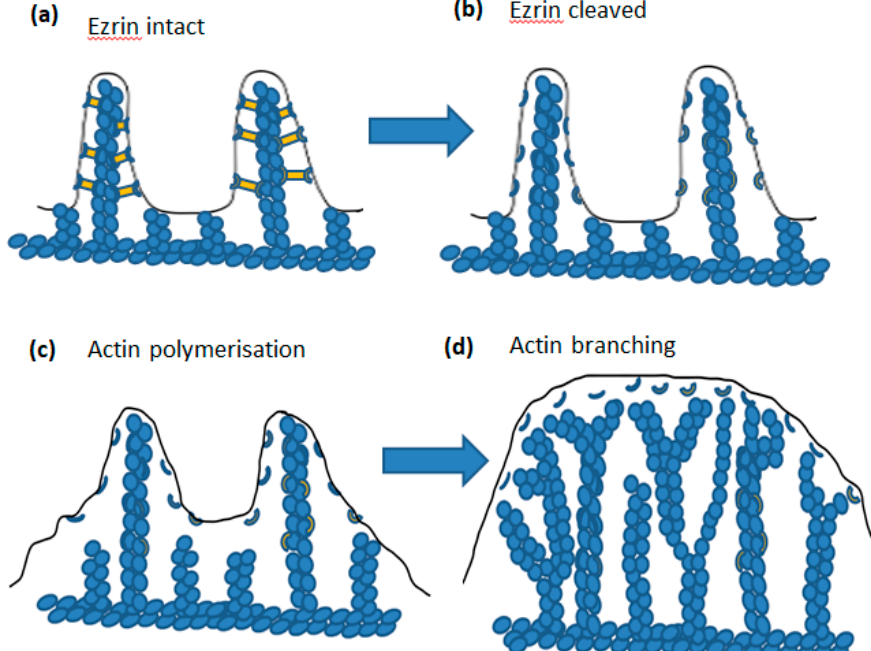
Figure 7. The sequence of intracellular molecular events leading to ”membrane expansion”. In ( a